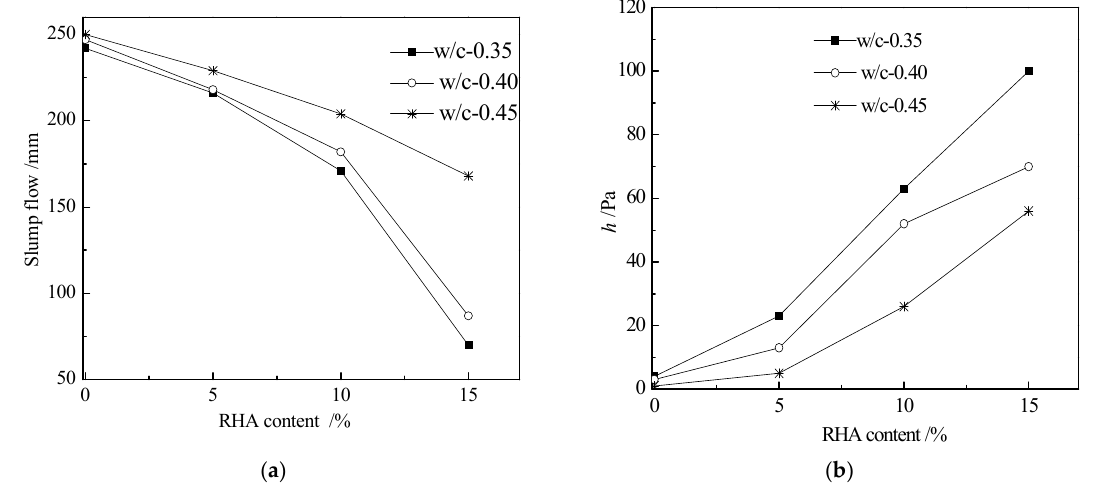
Figure 2. Slump flow and viscosity of fresh paste with different dosage of Rice husk ash (RHA): ( a ) Slump flow; ( b ) Viscosity.